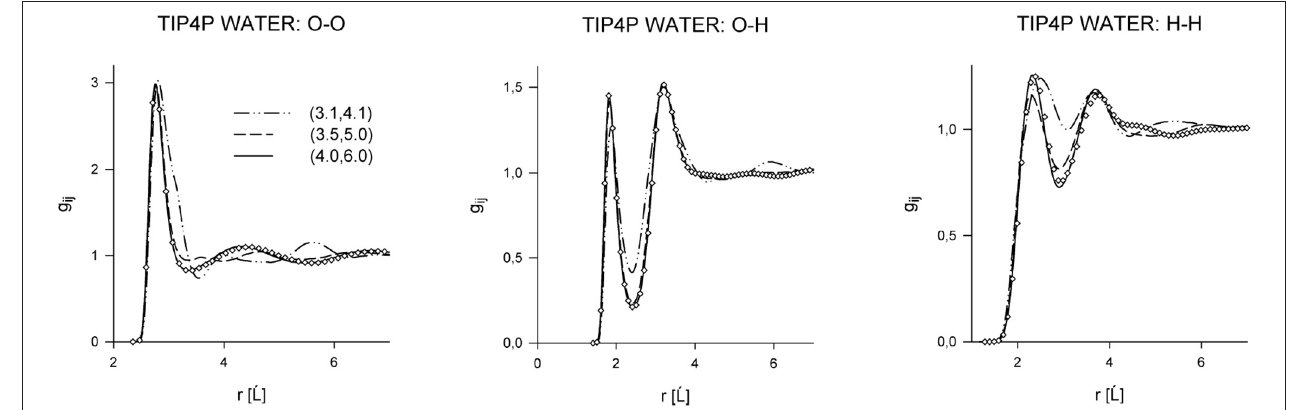
FIGURE 1 | Site-site correlation functions of TIP4P water at ambient conditions in dependence on the switching range, see Equation (25). Curves correspond to different switching ranges, and the circles are simulation results for the full